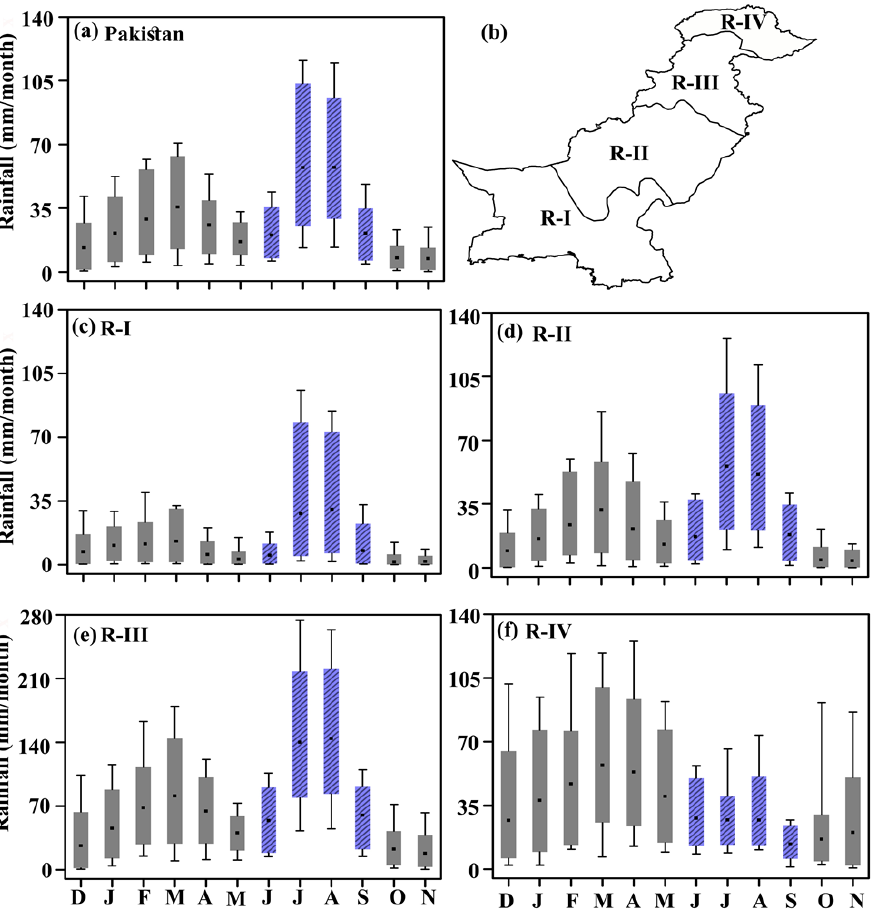
Figure 2. Annual cycle of the monthly total rainfall (unit: mm) in ( a ) Pakistan ( c ) hyper-arid (R-I), ( d ) arid (R-II), ( e ) humid (R-III), and ( f ) glacial (R-IV) regions for the 1980–2018 period. The blue boxes demarcate the months of the ISM season (from June to September). The long-term mean is shown by black dots, while the lines of the upper and lower whisk represent maximum and minimum rainfall, respectively. 5th (lower margin of the box), and 95th (upper margin of the box) percentiles of the rainfall are shown. The x -axis represents the month of the year starting from December. The four climate regions are shown in ( b ).